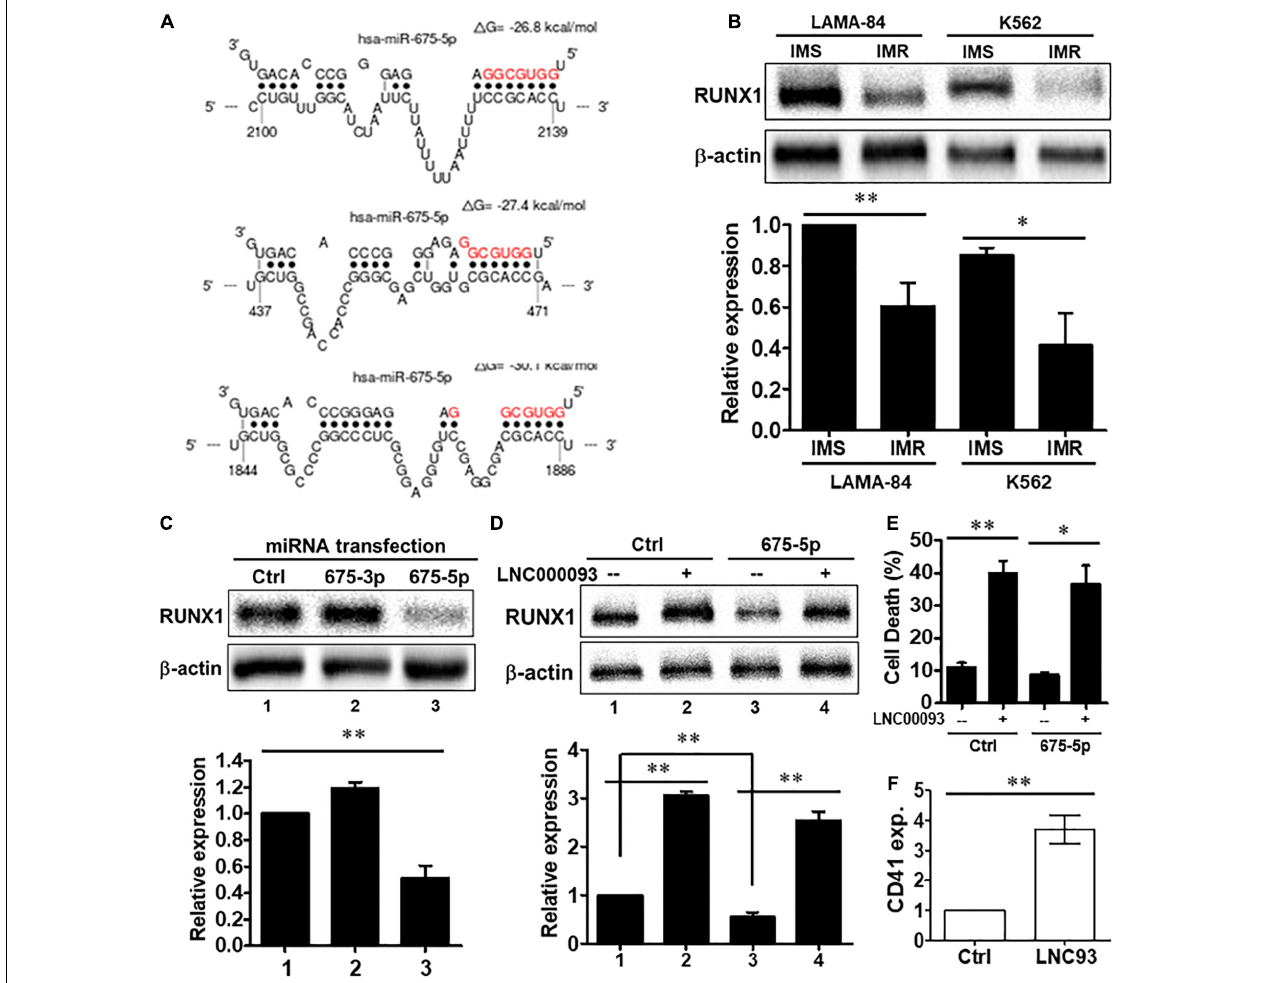
FIGURE 4 | miR-675-5p-suppressed cell death and RUNX1 expression in imatinib-resistant cells were rescued by LNC000093 expression. (A) In silico analysis revealed three putative binding sites of miR-675-5p on RUNX1. (B) Western blots showed a downregulation of RUNX1 in K562-IMR and LAMA84-IMR ( n = 3). The mean ± SD is shown for the results. ∗ P < 0.05, ∗∗ P < 0.01. (C) A downregulation of RUNX1 in K562 cells transfected with miR-675-5p mimics was revealed by Western blots ( n = 3). The mean ± SD is shown for the results. ∗∗ P < 0.01. (D) Western blots showed an enhanced expression of RUNX1 in cells